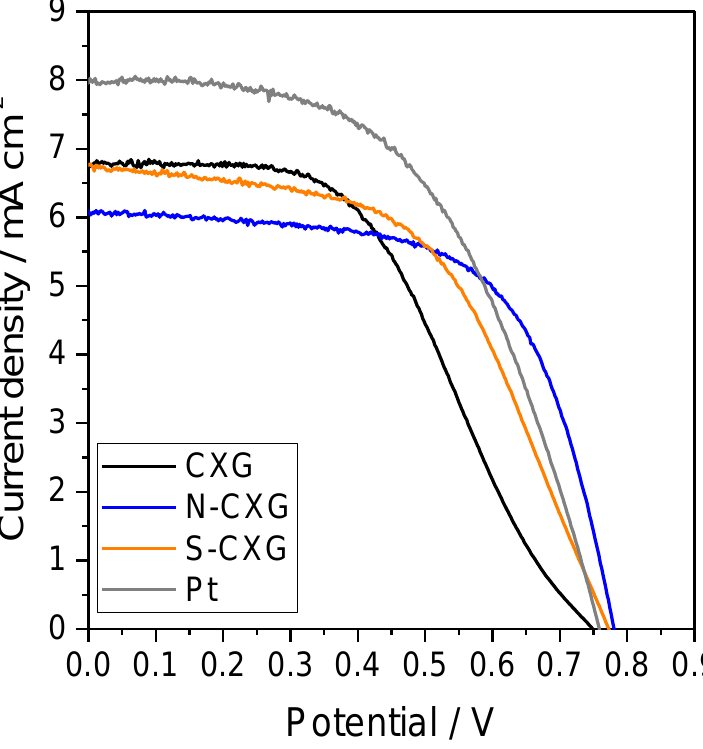
Figure 4. DSSC polarization curves for bare and doped carbon xerogels as counter electrodes and compared with Pt.